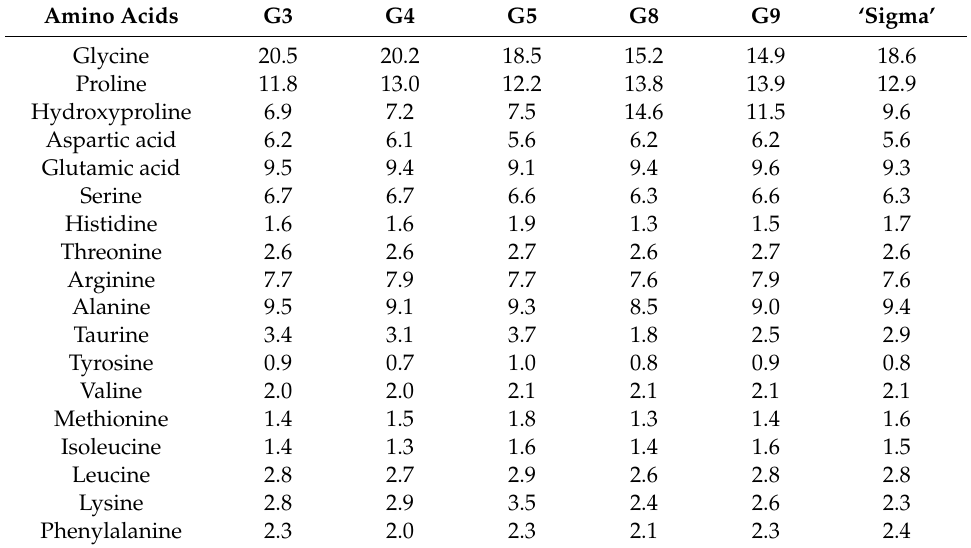
Table 2. Amino acid composition (amino acid content, g/100 g protein) of cod gelatin samples obtained at different рН and of a control sample.